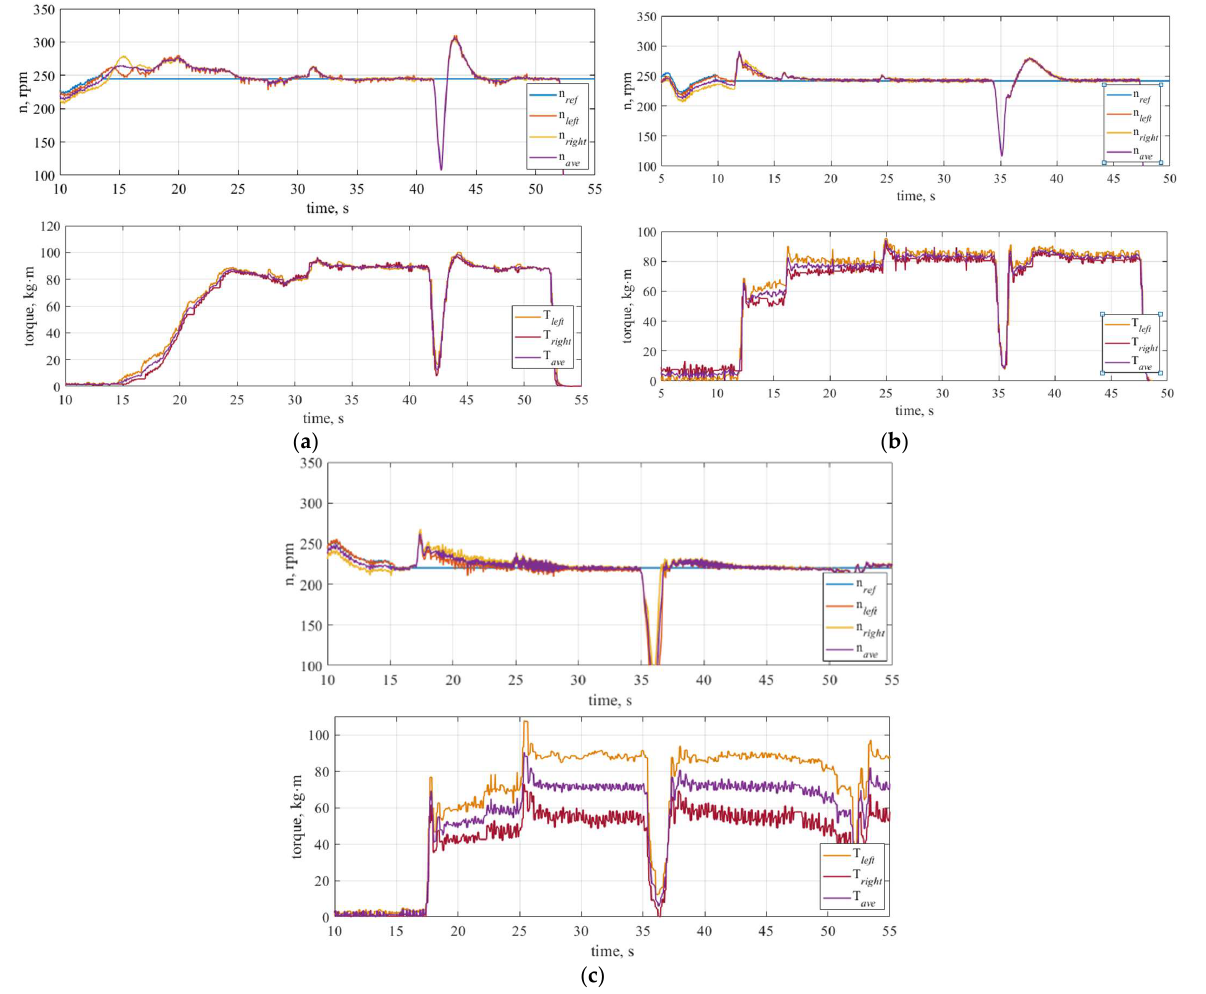
Figure 10. Graphs of transient processes of speed and torque with different controllers: ( a ) PID, ( b ) D γ I µ I, ( c ) PIDI γ I µ.